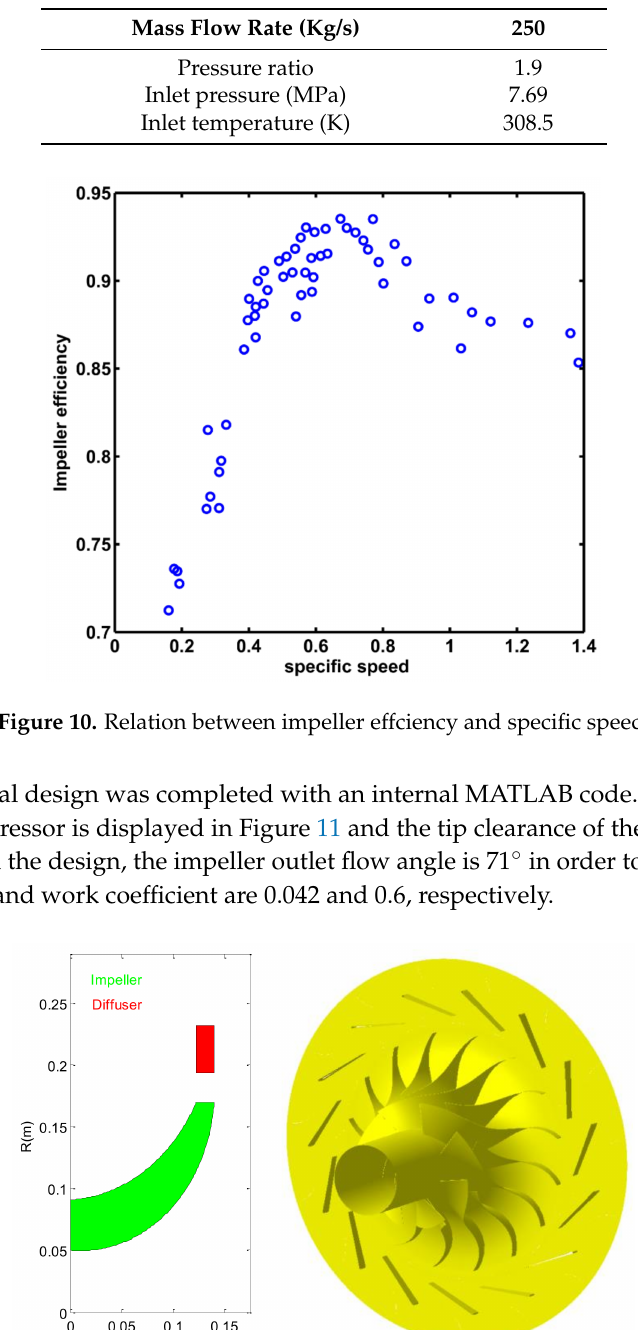
Table 4. Deign parameters for a 10 MWe centrifugal compressor.